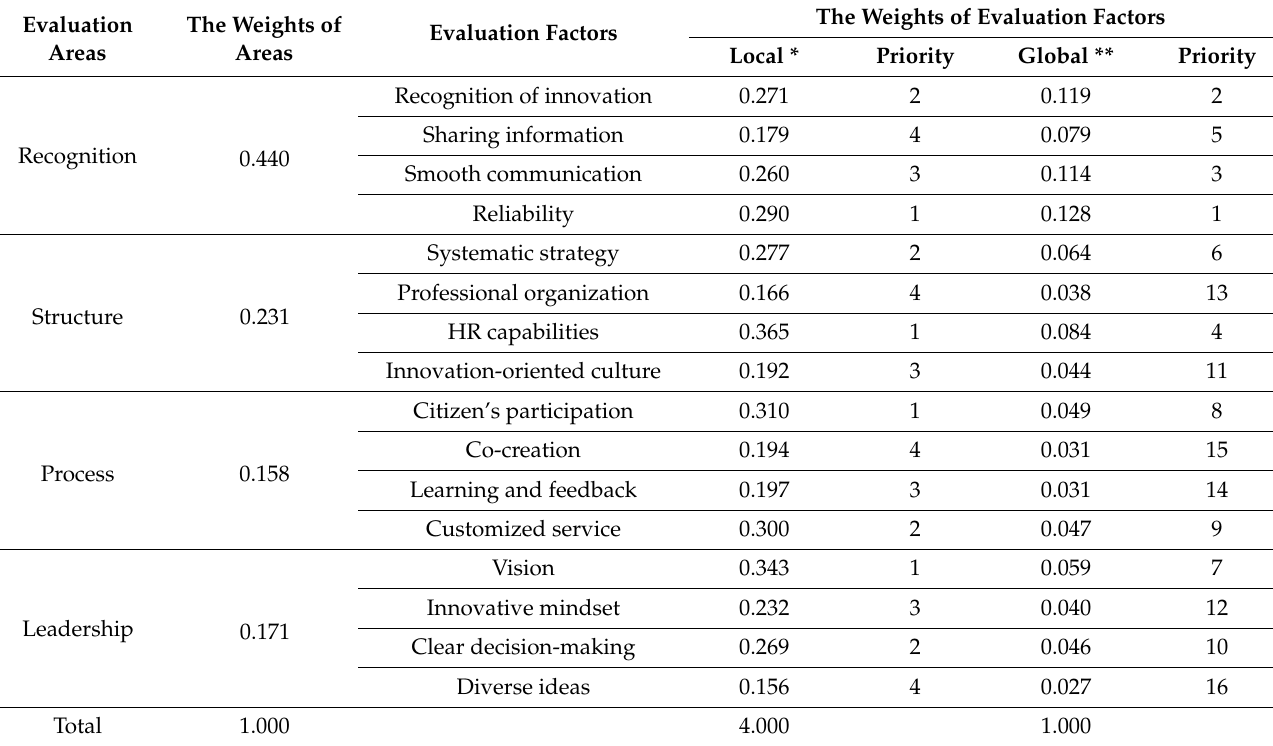
Table 6. Weights and priority of evaluation variables.